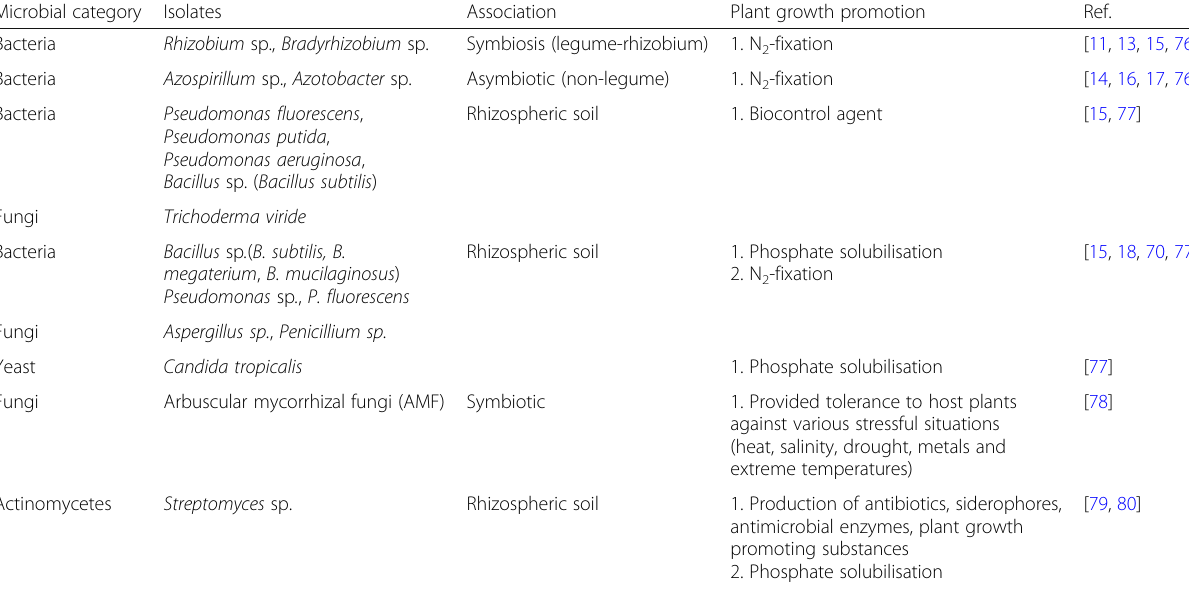
Table 3 EMs and their specific roles in plant growth promotion Microbial category